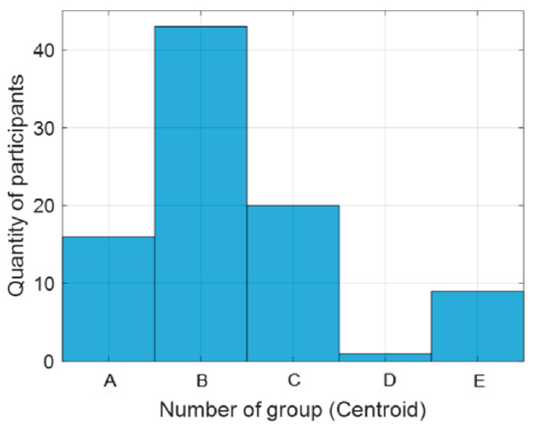
Figure 7. Frequency chart that relates the number of participants labelled in every group (clusters). The capital letter in the x axis indicates the five found clusters.